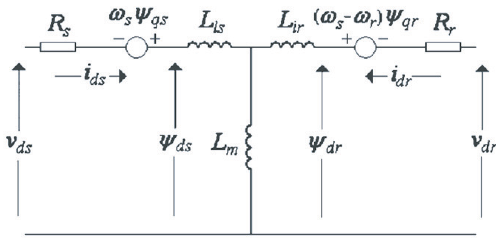
Figure 6. Equivalent circuit of the DFIG in the d